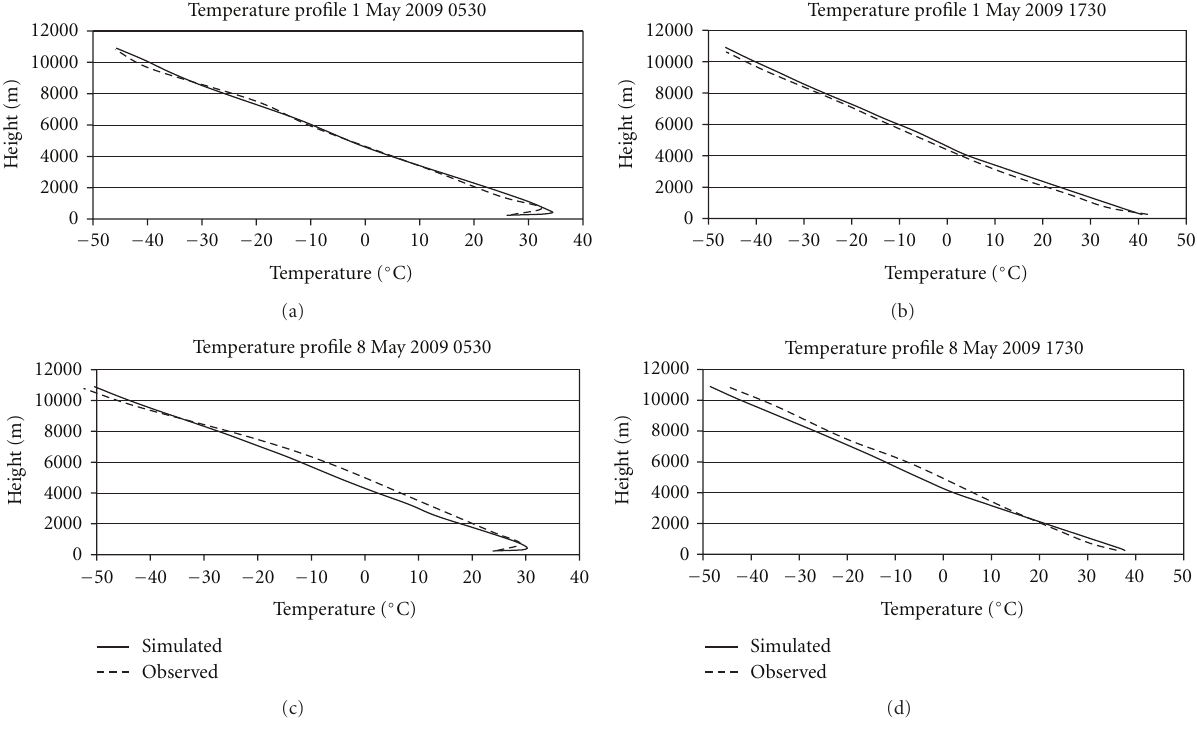
Figure 7: Temperature profile of selected days: 1 May 2009 and 8 May 2009 at 0530 1730 IST.